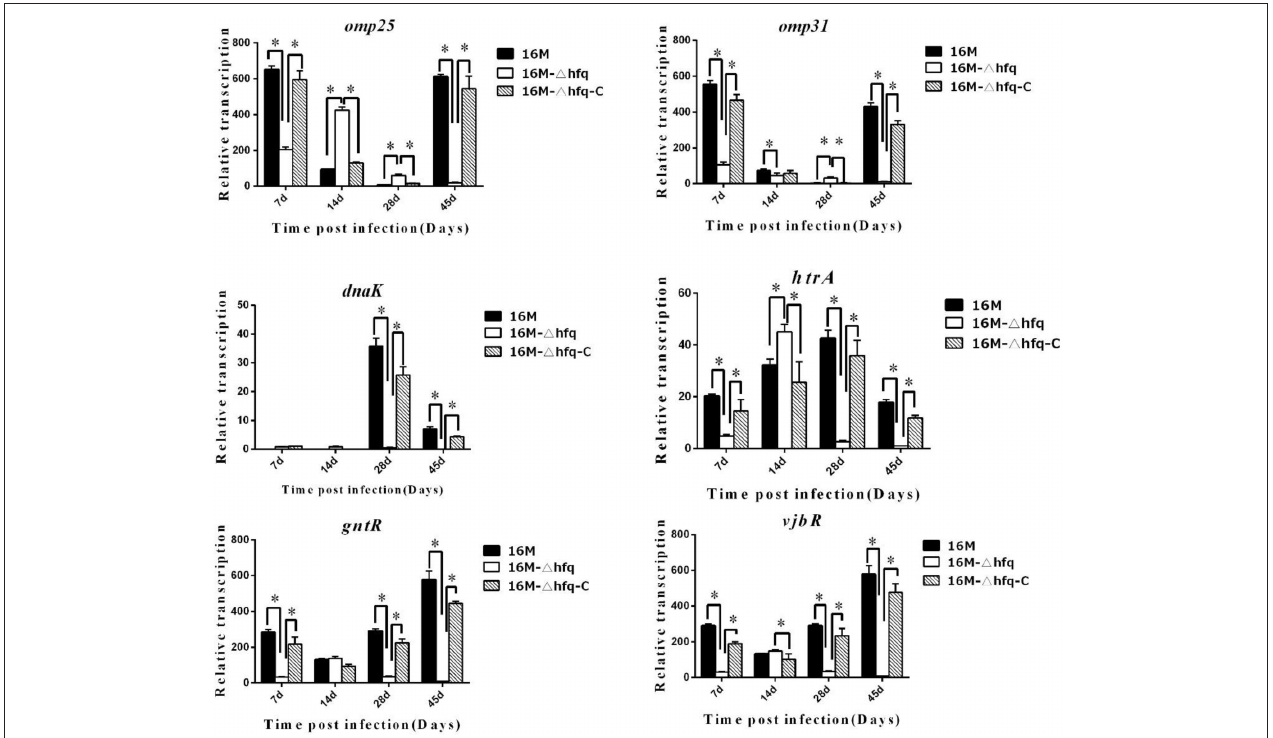
FIGURE 2 | hfq regulates the expression of genes related to virulence during infection. BALB/c mice were infected with B. melitensis 16M, 16M △ hfq, and 16M △ hfq-C, and then RNA was isolated from the spleens at 7, 14, 28, and 45 days post-infection. The relative transcription levels of virulence genes, omp25, omp31, dnaK, htrA, gntR , and vjbR , were determined by quantitative RT-PCR. The data were compared to the expression under standard in vitro conditions (TSB) of 16M. Significant differences between the mutant and parent strain were indicated as follows: * P < 0.001